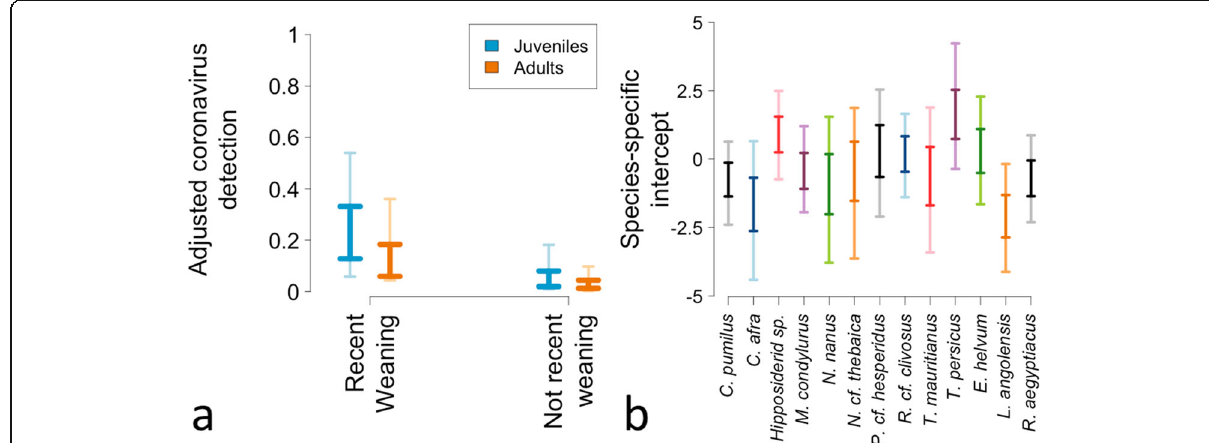
Fig. 3 a Modeled proportion of chiropterans shedding coronavirus viral particles in two reproductive periods inferred for these bats by age class. b The estimated species-specific intercept coefficients. The lighter colors represent the range where the 90% of the estimated detection values are concentrated (the High Posterior Density Interval). The darker colors show the 51% High Posterior Density